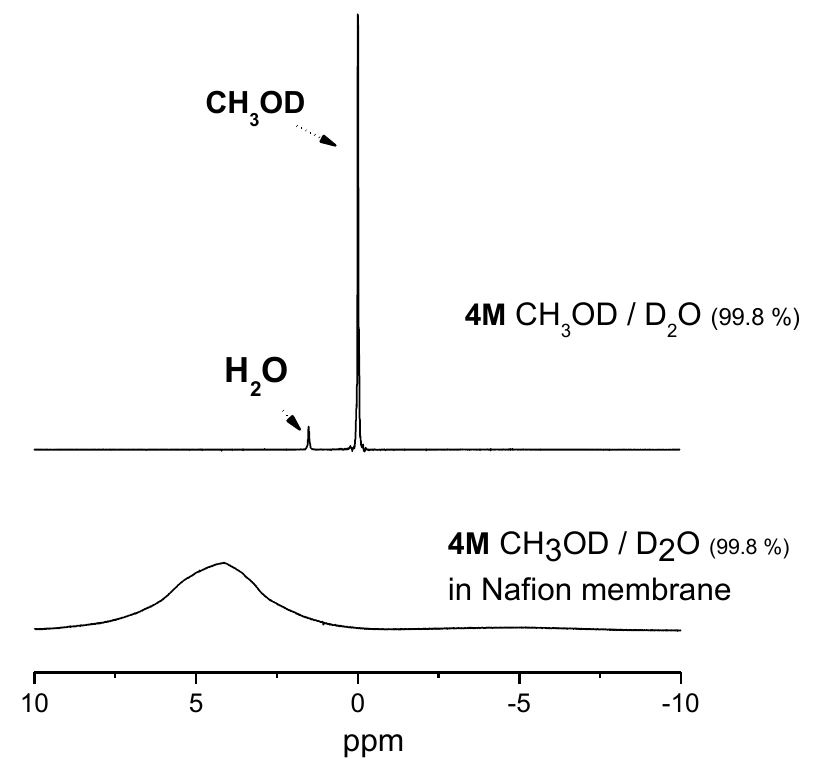
Figure 1. 1 H-NMR spectra recorded on 4 M aqueous methanol solution (CH 3 OD/D 2 O) as prepared and confined in Nafion membrane, respectively. The chemical shift variation of the methanol's signal is caused by the different chemical environment and the strong interactions with the polymer